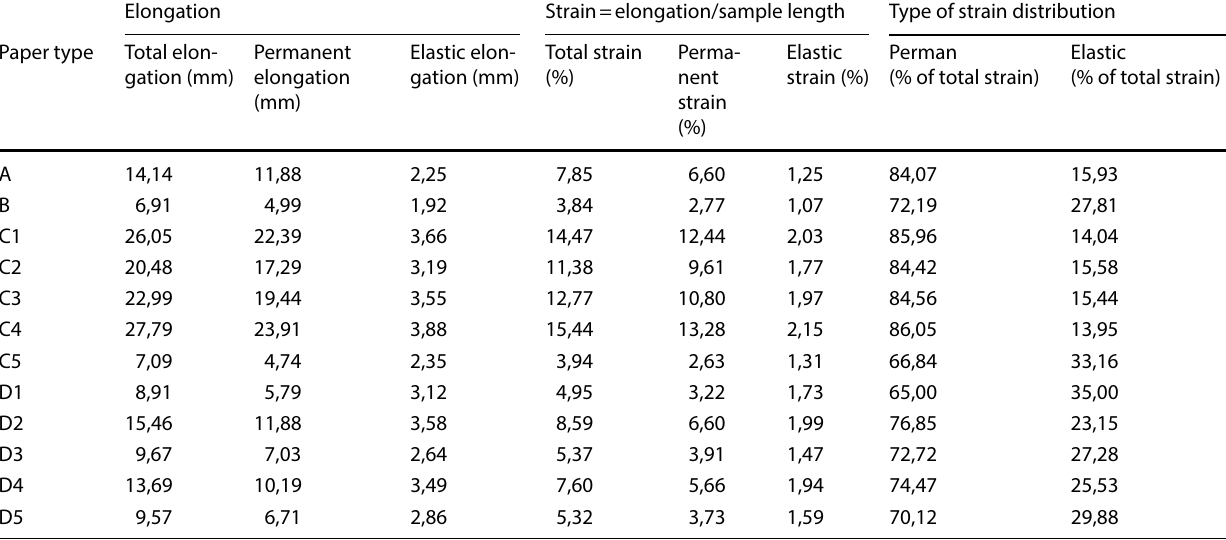
Table 4 Averaged results of elastic contraction tests following a force of 50% of ultimate force Elongation Strain = elongation/sample length Type of strain